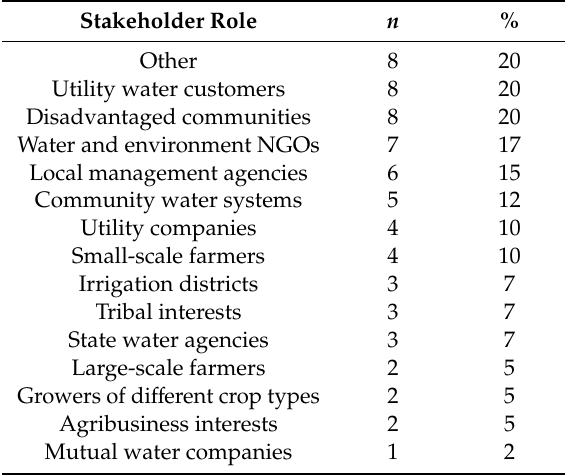
Table 1. Game participant stakeholder identity in groundwater